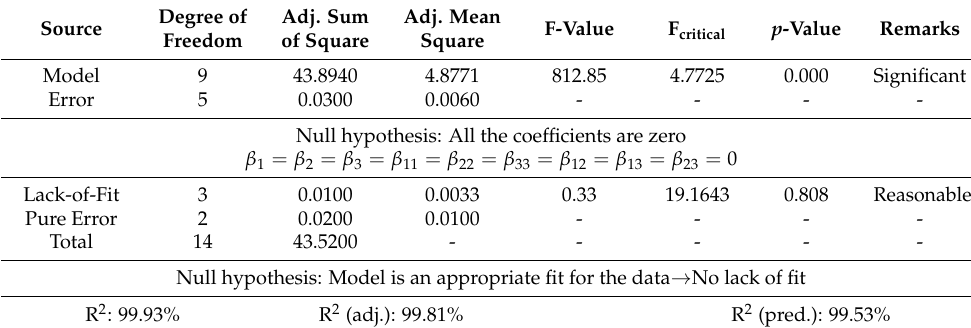
Table 5. Analysis of variance (ANOVA) for the fitted